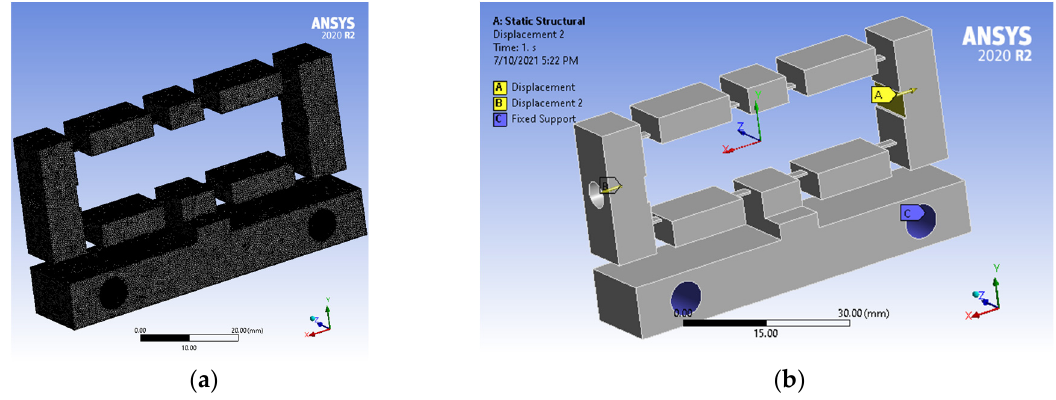
Figure 1. Developed compliant mechanism model of bridge-type: ( a ) 2D drawings, and ( b ) 3D drawing.